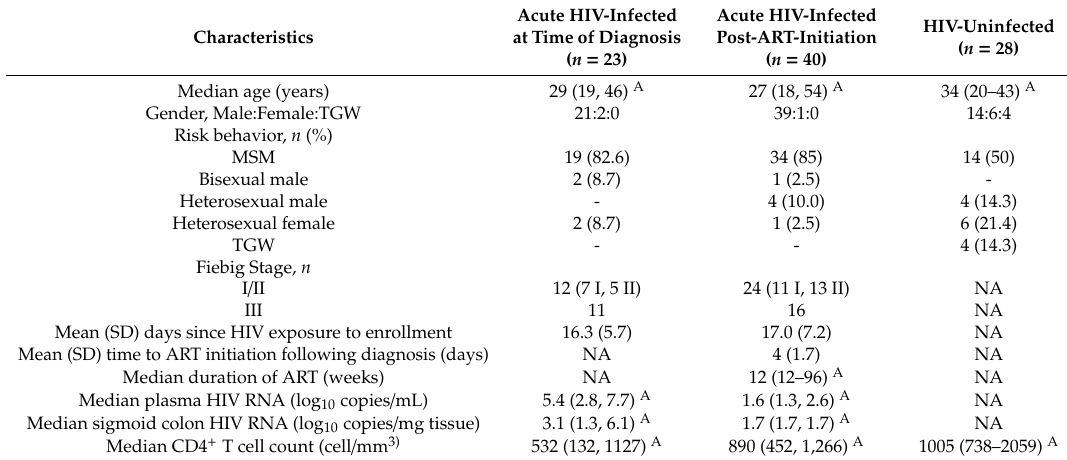
Table 2. Clinical, immunological, and virological characteristics and demographics of RV254 / SEARCH 010 and RV304 / SEARCH 013 study